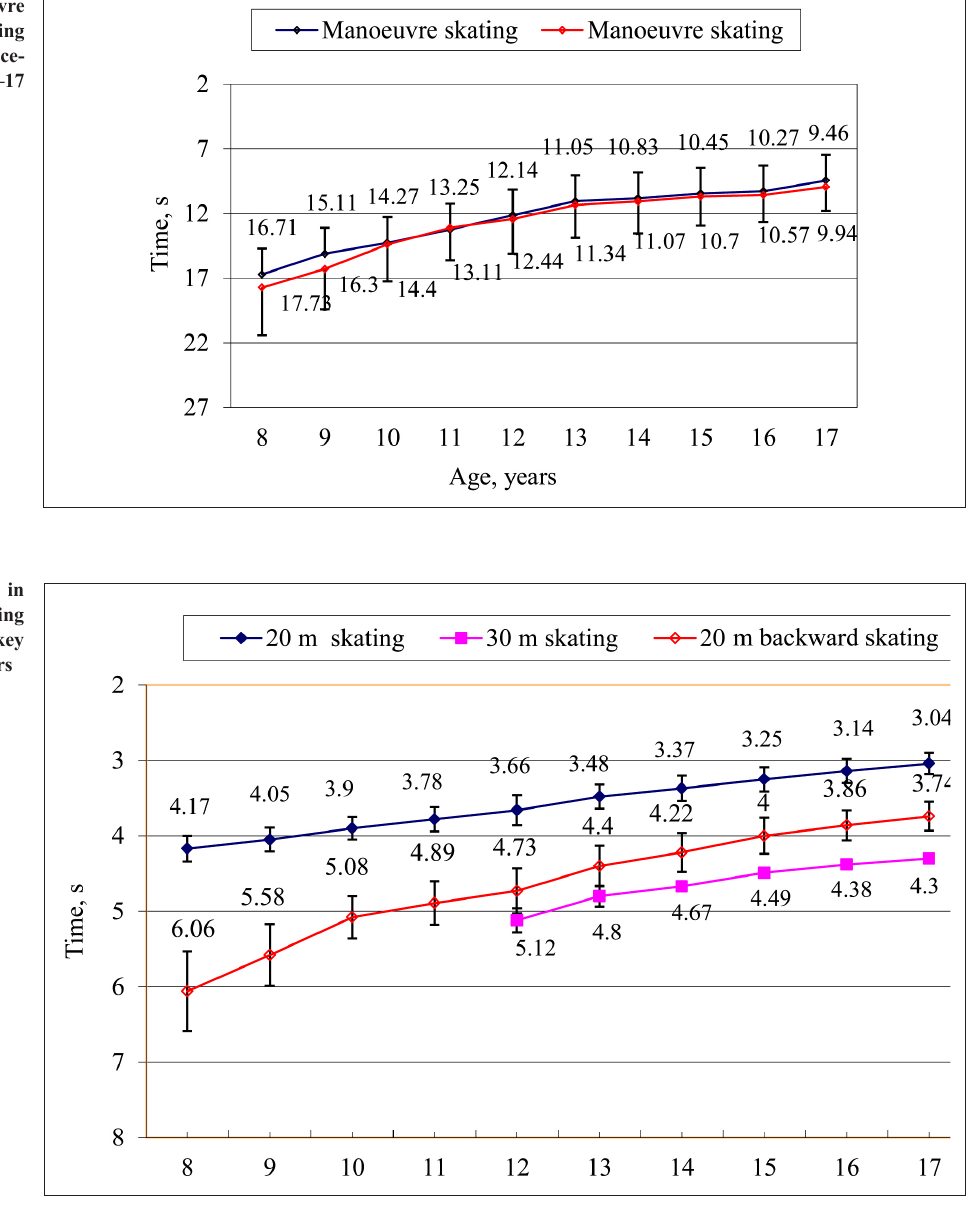
Figure 2. Changes in results of manoeuvre